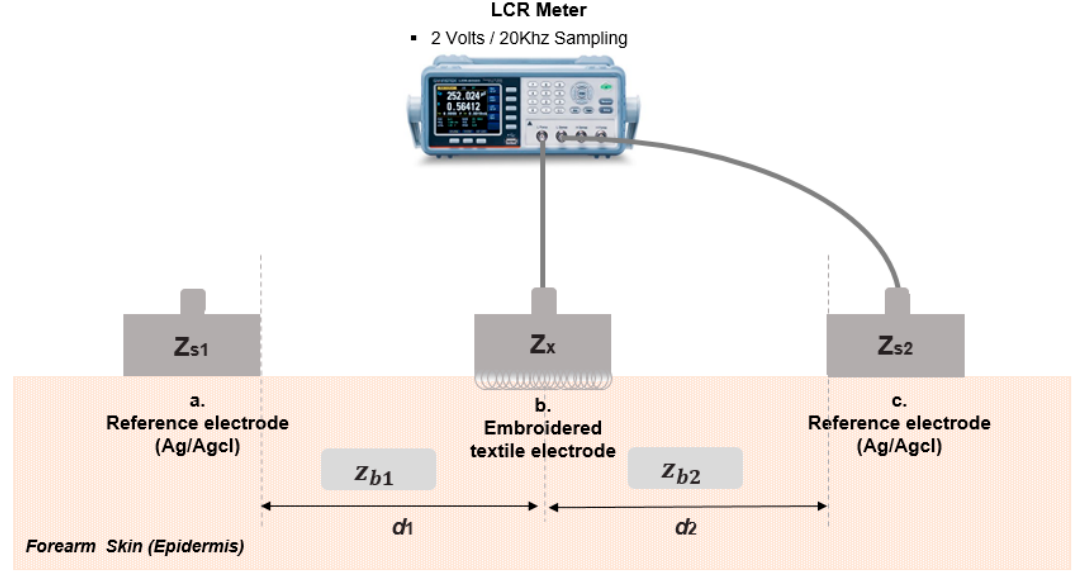
Figure 5. Experimental setup for the skin-electrode impedance measurement.